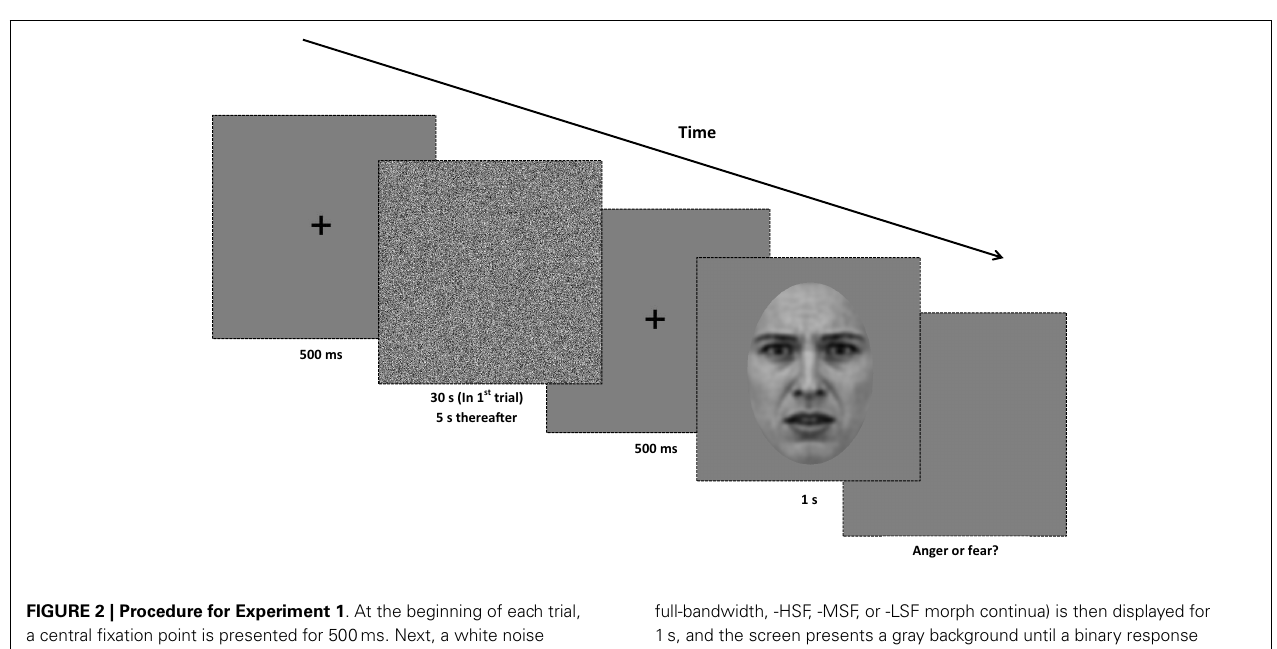
FIGURE 2 | Procedure for Experiment 1 . At the beginning of each trial, a central fixation point is presented for 500ms. Next, a white noise adaptor is presented for 30s in the first trial of the block, and for 5s in every subsequent trial. After the noise stimulus, the central fixation point is displayed for another 500ms. A test image (from either the